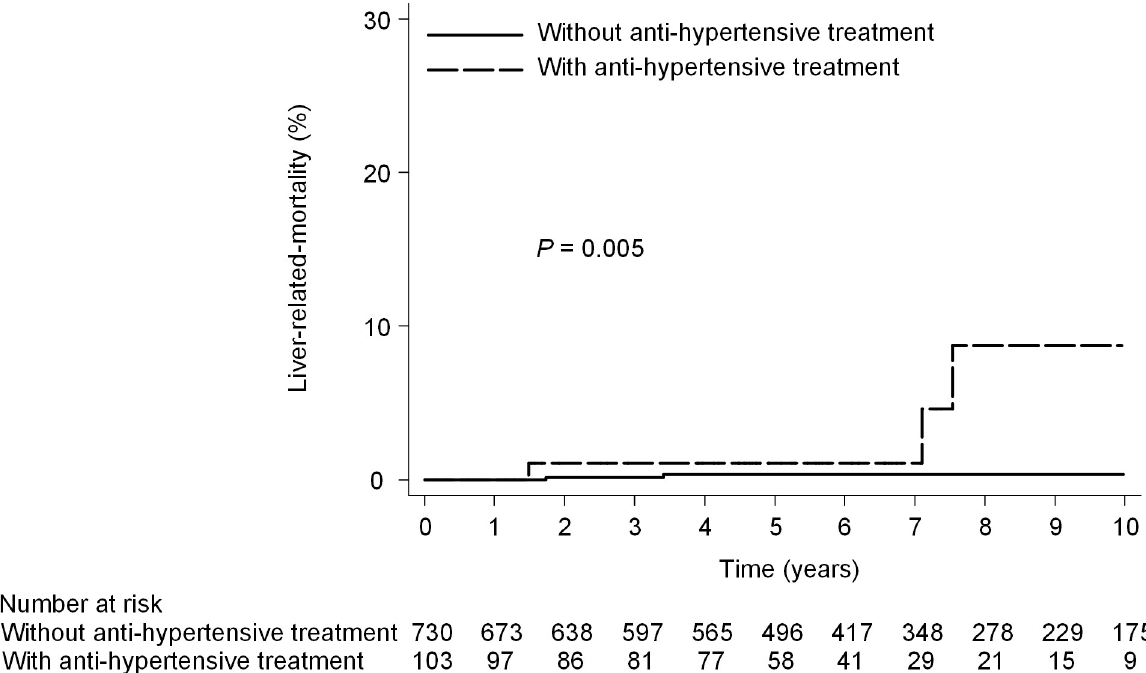
Fig 6. Liver-related mortality according to anti-hypertensive treatment. (10- year mortality rate, 0.3% vs 8.8%; HR, 10.3; 95% CI, 2.0–52.3; P = 0.005).